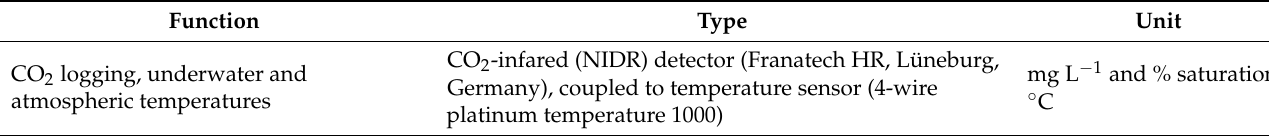
Table 2. Inventory of main functions in the microalgae (diatom) mass cultivation project.